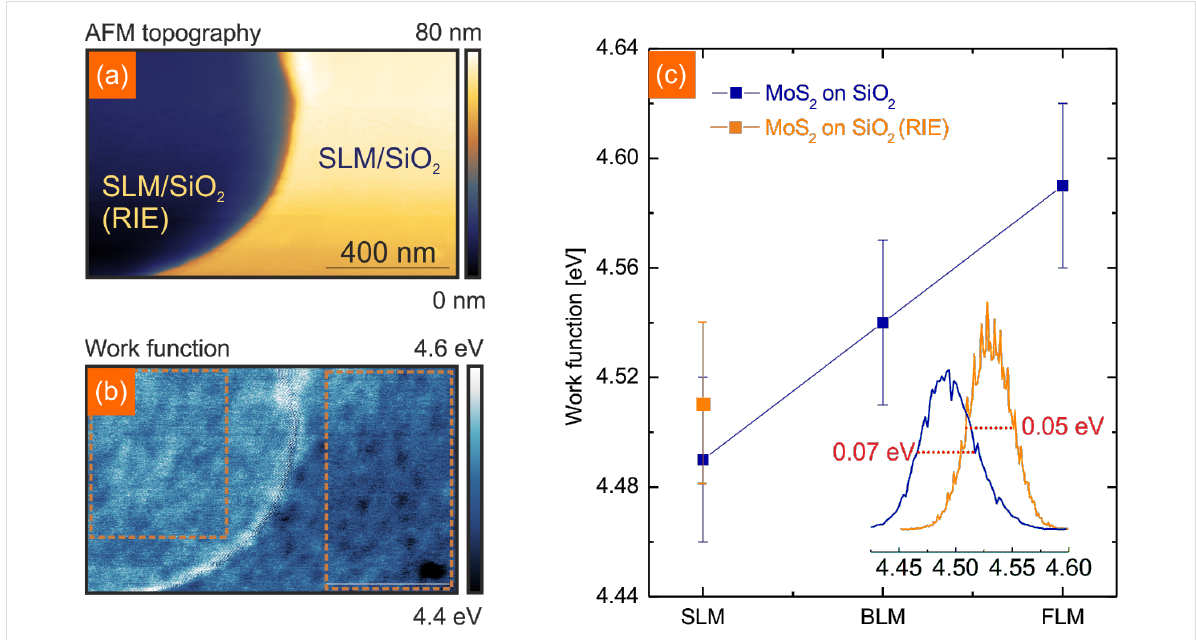
Figure 5: (a) NC-AFM topography of SLM on SiO 2 and holes etched in SiO 2 using RIE. (b) Work function map corresponding to the topography shown in (a). The work function of SLM on etched SiO 2 is increased compared to pristine SiO 2 . (c) Layer dependent work function of MoS 2 . The inset shows the work function histogram evaluation of the areas marked in (b). The FWHM of SLM on RIE SiO 2 is decreased by 0.02